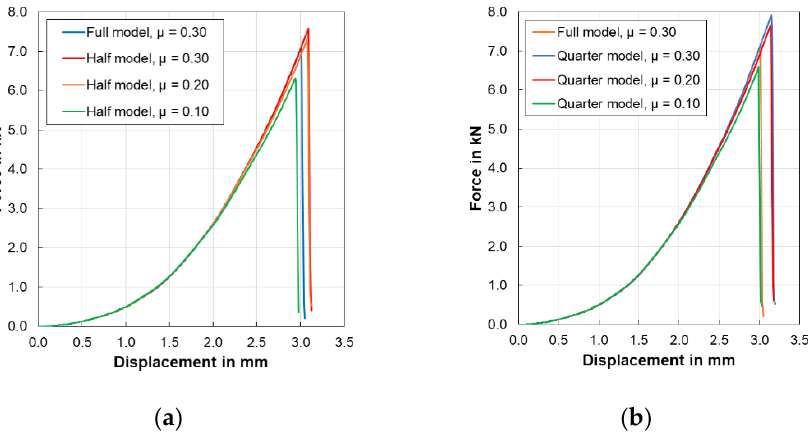
Figure 19. Force-displacement outputs using the partial modelling method: ( a ) influence of coefficient of friction on half model; ( b ) influence of coefficient of friction on quarter model.